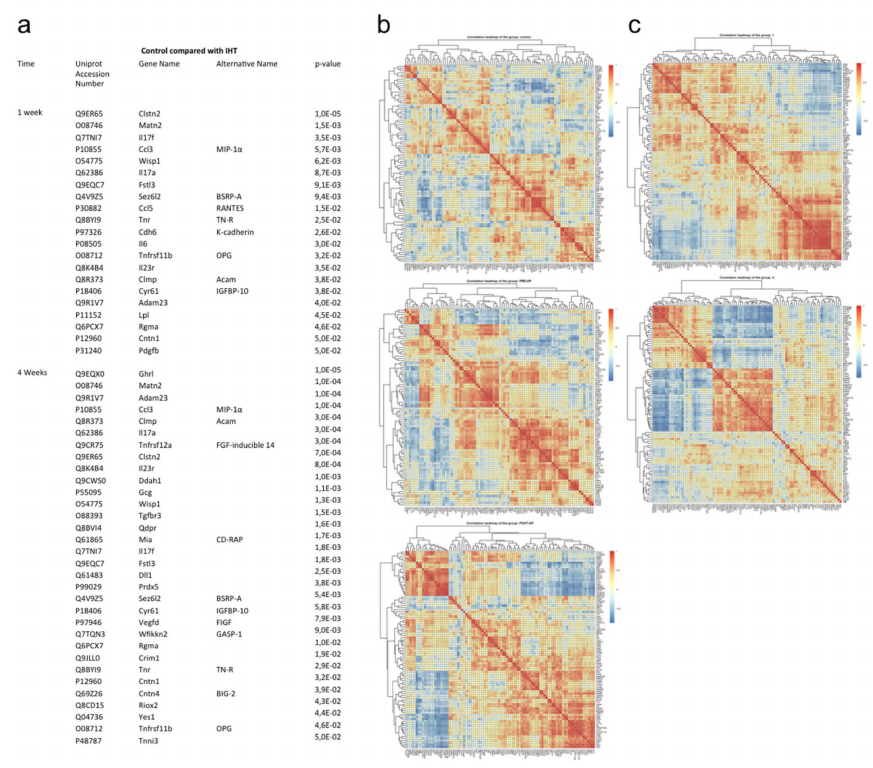
Figure 5. Systemic explorative proteins of interest. ( a ) Proteins and their gene abbreviations that showed significant difference using one-way ANOVA or the Kruskal–Wallis rank test. Data are shown as unadjusted NPX data, control versus Intermittent Hypoxic Therapy (IHT). Abbreviations: Calsyntenin 2, Clstn2; Matrilin-2, Mats2; Interleukin-17F, Il17f; C-C motif chemokine 3, Ccl3; WNT1- inducible-signaling pathway protein 1, Wisp1; Interleukin-17A, Il17a; Follistatin-related protein 3, Fstl3; Seizure 6-like protein 2, Sez6l2; C-C motif chemokine 5, Ccl5; Tenascin-R, Tnr; Cadherin- 6, Cdh6; Interleukin-6, Il6; Tumor necrosis factor receptor superfamily member 11B, Tnfrsf11b; Interleukin-23 receptor, Il23r; CXADR-like membrane protein, Clmp; Protein CYR61, Cyr61; Dis- integrin and metalloproteinase domain containing protein 23, Adam23; Lipoprotein lipase, Lpl; Repulsive guidance molecule A, Rgma; Contactin-1, Cntn1; Platelet-derived growth factor subunit B, Pdgfb; Appetite-regulating hormone, Ghrl; Tumor necrosis factor receptor superfamily mem- ber 12 A, Tnfrsf12a; N(g),N(G)-dimethylarginine dimethylaminohydrolase 1, Ddah1; Glucagon, Gcg; Transforming growth factor beta receptor type 3, Tgfbr3; Dihydropteridine reductase, Qdpr; Melanoma-derived growth regulatory protein, Mia; Delta-like protein 1, DII1; Peroxiredoxin-5, mitochondrial, Prdx5; Vascular endothelial growth factor D, Vegfd; WAP Kazal immunoglobulin Kunitz and NTR domin-containing protein 2, Wfikkn2; Cysteine-rich motor neuron 1 protein, Crim1; Contactin-4, Cntn4; Ribosomal oxygenase 2, Riox2; Tyrosine-protein kinase Yes, Yes1; Troponin I, car- diac muscle, Tnni3. ( b , c ) Clustered heatmaps and the correlation between protein expression within groups and time were determined using the Pearson’s correlation analysis across all NPX values.